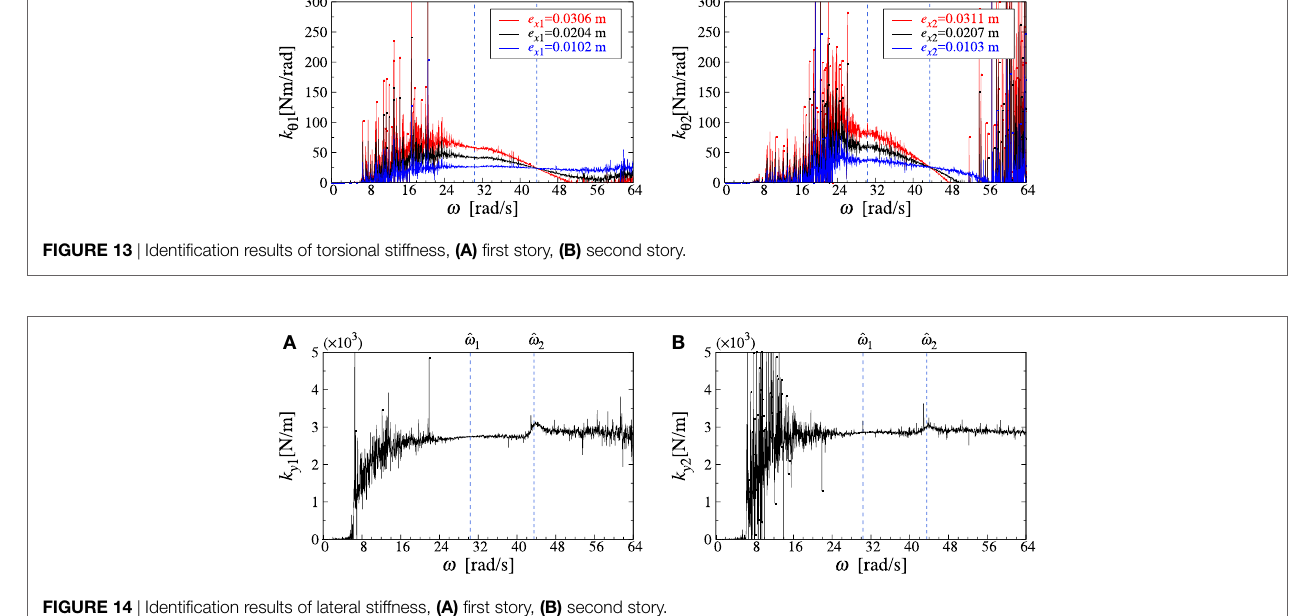
FIGURE 14 | Identification results of lateral stiffness, (A) first story, (B) second story.